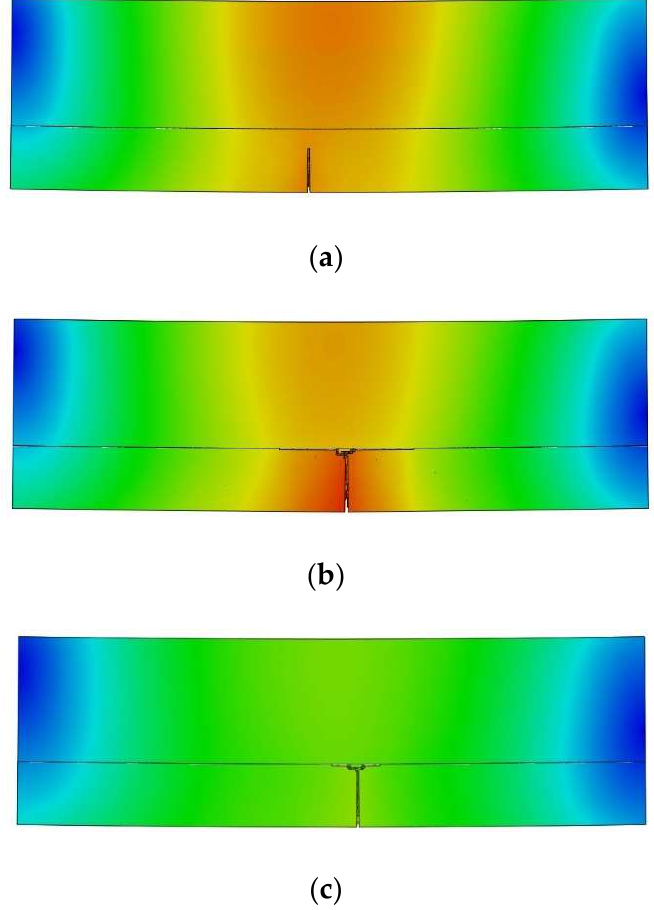
Figure 14. Displacement maps of the RVE models: ( a ) model_1 (fi = 0.25 mm); ( b ) model_2 (fi = 0.19 mm); and ( c ) model_3 (fi = 0.15 mm).